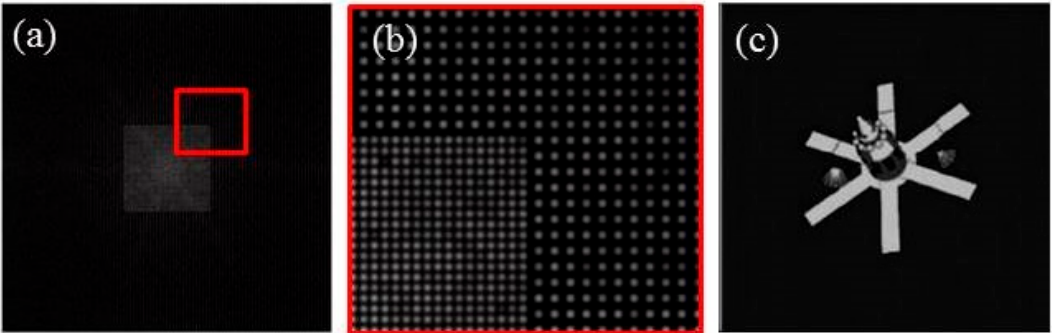
Figure 9. ( a ) Mutual intensity spectrum detected with the complex rectangular sub-aperture arrangement method ( (cid:52) u1 = 0.66, (cid:52) u2 = 0.99, N = 200); ( b ) partial enlargement of the spectrum; ( c ) actual imaging of the